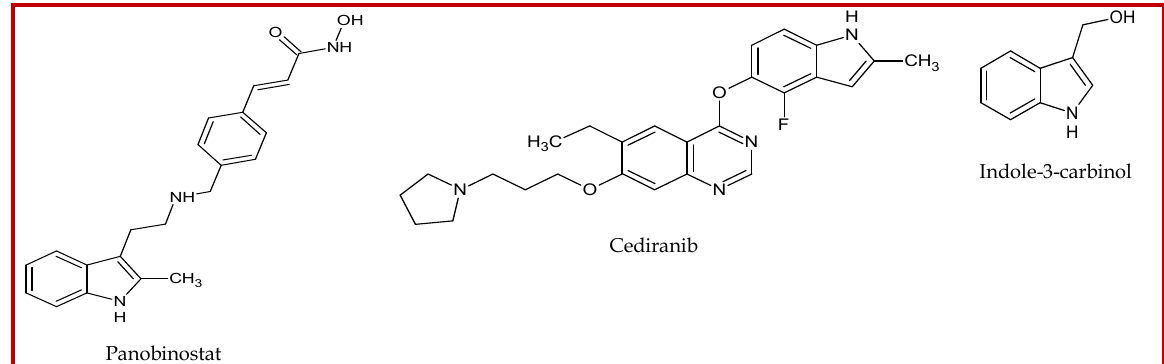
Figure 1: Anti-cancer drugs having indole ring